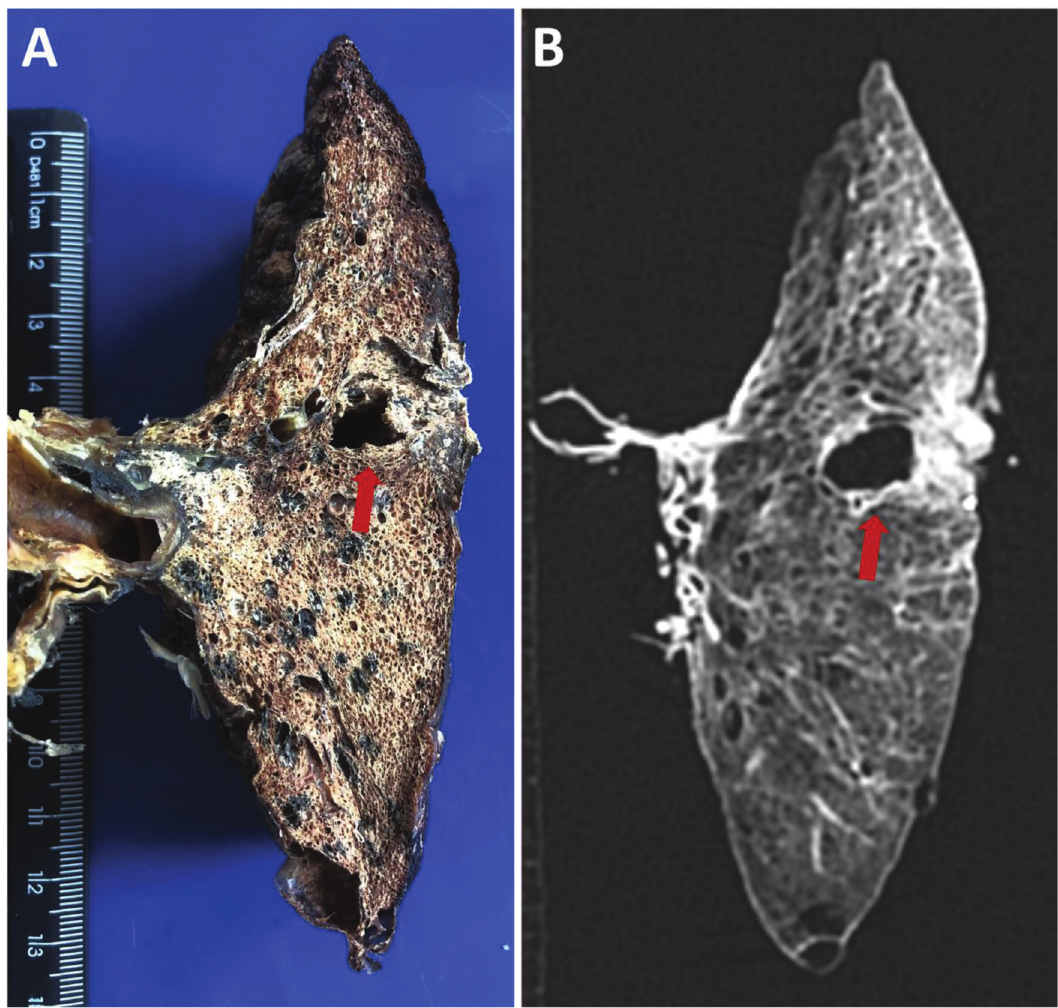
Figure 5 - Male, 89 years old, 7 days of hospitalization, same patient as in Figure 3A and 3B . Ex-situ computed tomography (B) showing perfect correlation with the macroscopic evaluation of the lung (A) , ground-glass opacities, peripheral reticular pattern, and an area of lung cavitation (arrow in A and B ), likely resulting from a previous abscess, with fistula formation toward the